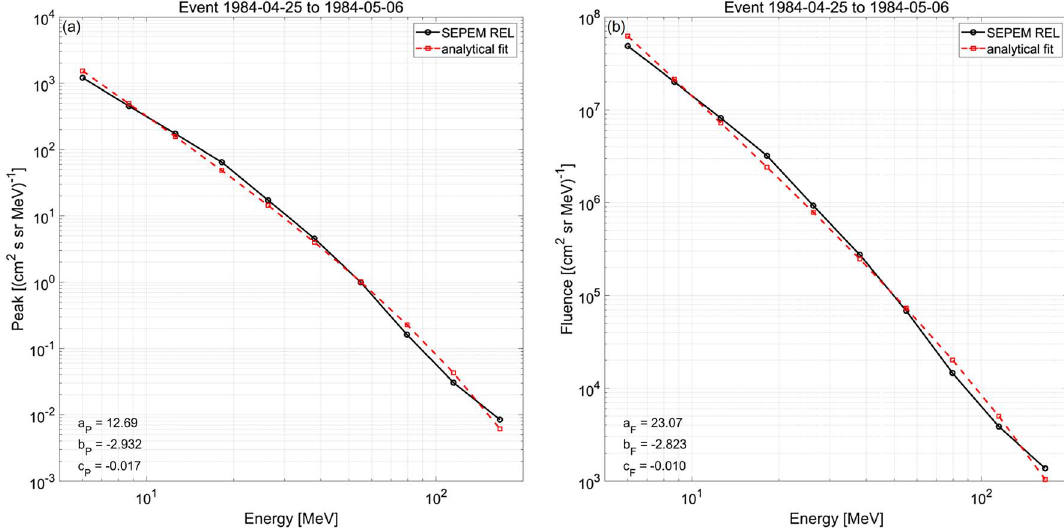
Fig. 3. (a) Peak spectrum derived from SEPEM RDS for an SPE Event and the analytical fi t made with exponential cut-off power-law. (b) Same for respective Fluence spectrum. The fi tted spectral parameters can be seen in the bottom left corners.